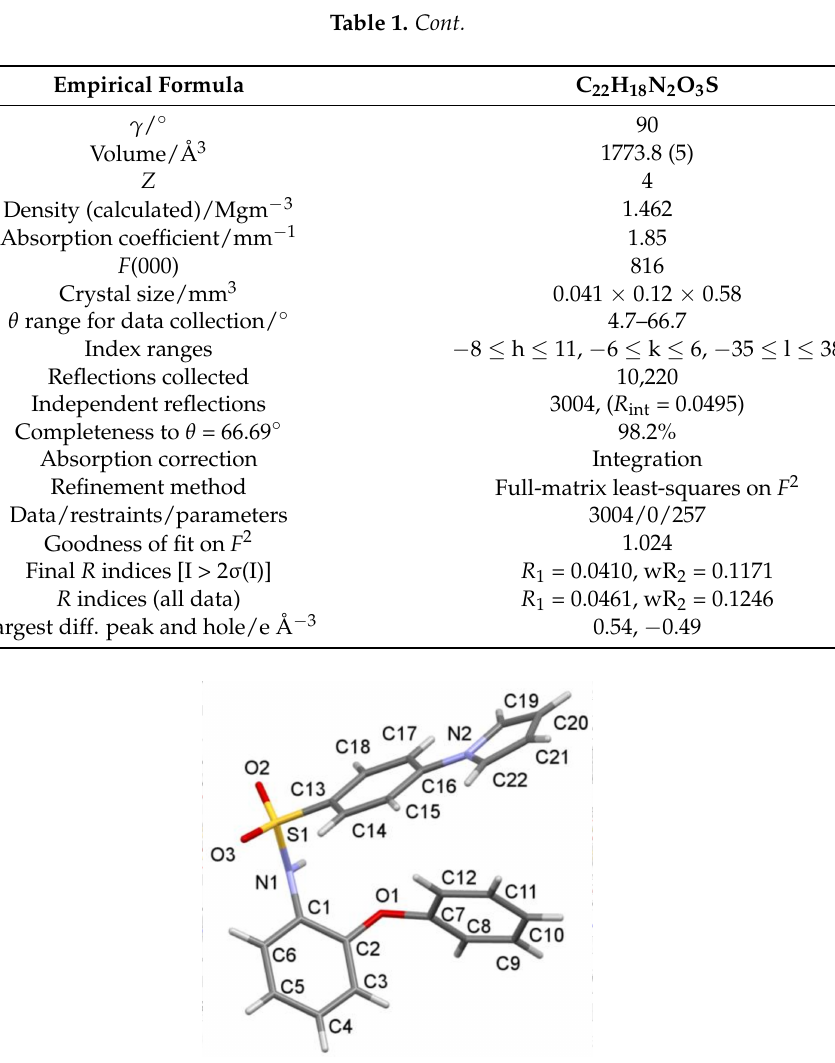
Figure 3. Atom numbering scheme for 25 , hydrogen atoms not labelled for clarity. Selected bond lengths [Å] and angles [ ◦ ]: S1–O2 1.4287(14), S1–O3 1.4336(14), S1–N1 1.6300(17), S1–C13